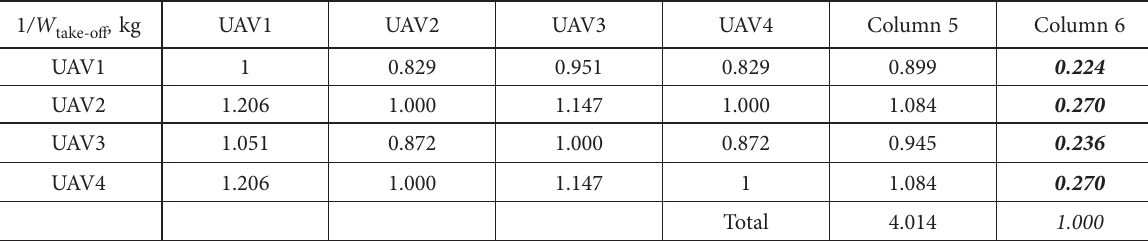
Table 11. Matrix of take-off weight 1 /W take-off , kg